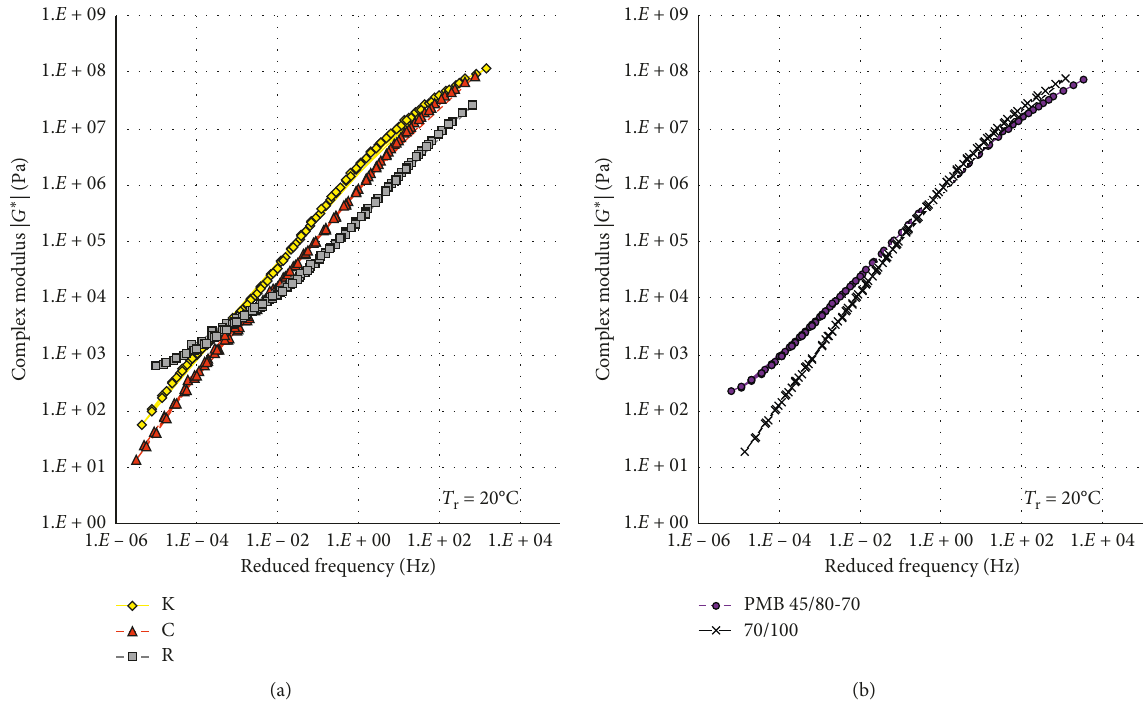
Figure 5: | G ∗ | master curves for the selected binders in comparison with bituminous